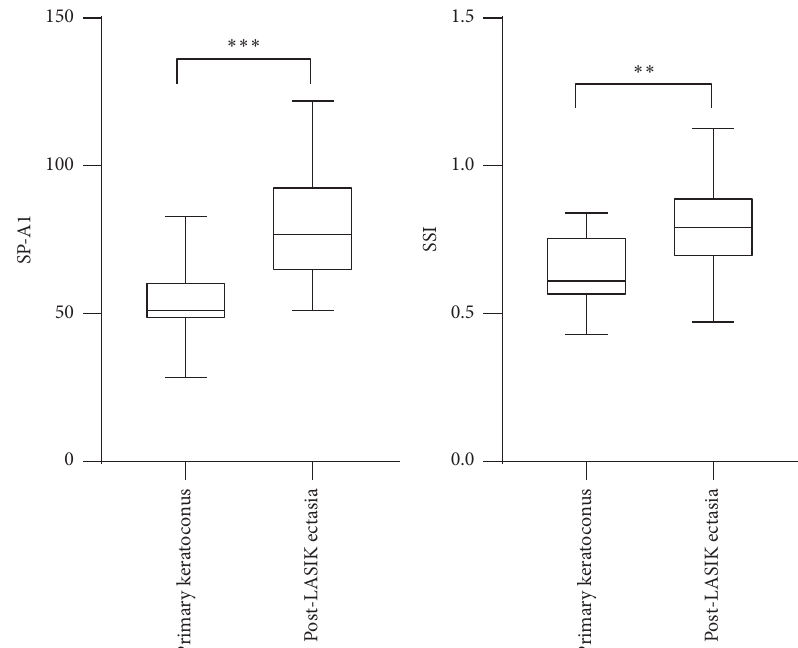
Figure 3: Significant differences in stiffness parameter at the first applanation (SP-A1, left) and the stress-strain index (SSI, right) between the post-LASIK ectasia and primary keratoconus groups ( p ≤ 0 . 001, p � 0 . 001, ∗∗∗ p ≤ 0.001, and ∗∗ p � 0.01